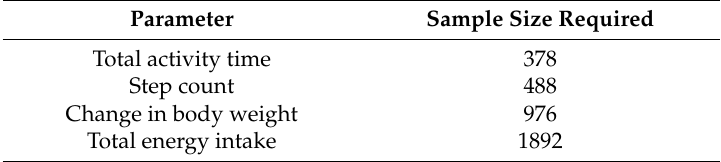
Table 7. Sample size calculations based on outcomes of SMART MUMS WITH SMART